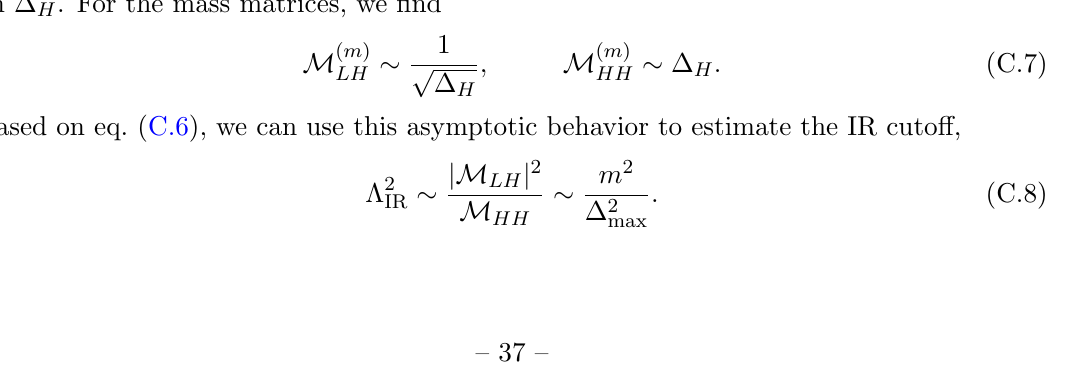
Figure 15 . Three-particle Casimir eigenstate matrix elements, with overall factors of m 2 and (cid:21) removed, as a function of the larger of the two operator scaling dimensions, (cid:1) H , for the mass term (top), n ! n interaction (middle) and n ! n + 2 interaction (bottom). Left: matrix elements involving the lowest-dimension operator ((cid:1) L = 3). Right: matrix elements where both operators have dimension (cid:1) H